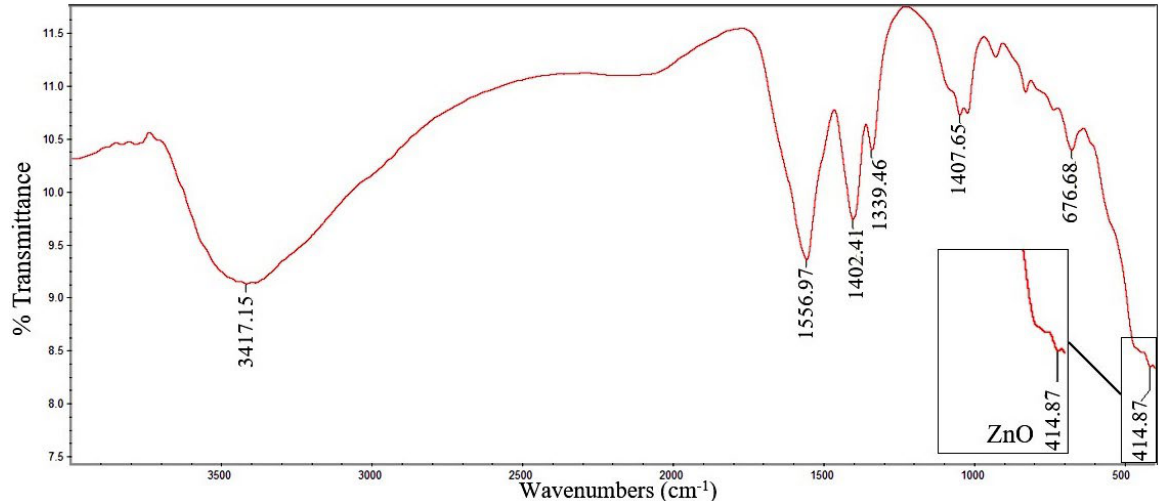
Figure 5. FT-IR spectrum of synthesized ZnO